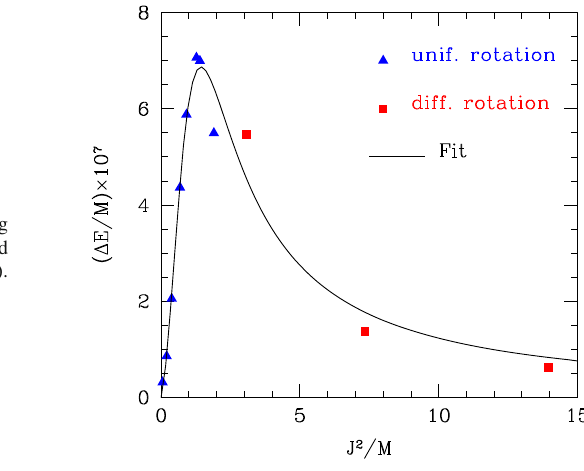
Fig. 25 Energy carried off by gravitational waves, normalized to the total initial mass M , as a function of J 2 / M for collapsing, rapidly rotating neutron stars initially modeled as n = 1 polytropes. Triangles represent uniformly rotating models, whereas the squares refer to the differentially rotating models discussed here. The solid line is the best fit (see Eq. (138)). (Image reproduced with permission from Giacomazzo et al. 2011, copyright by